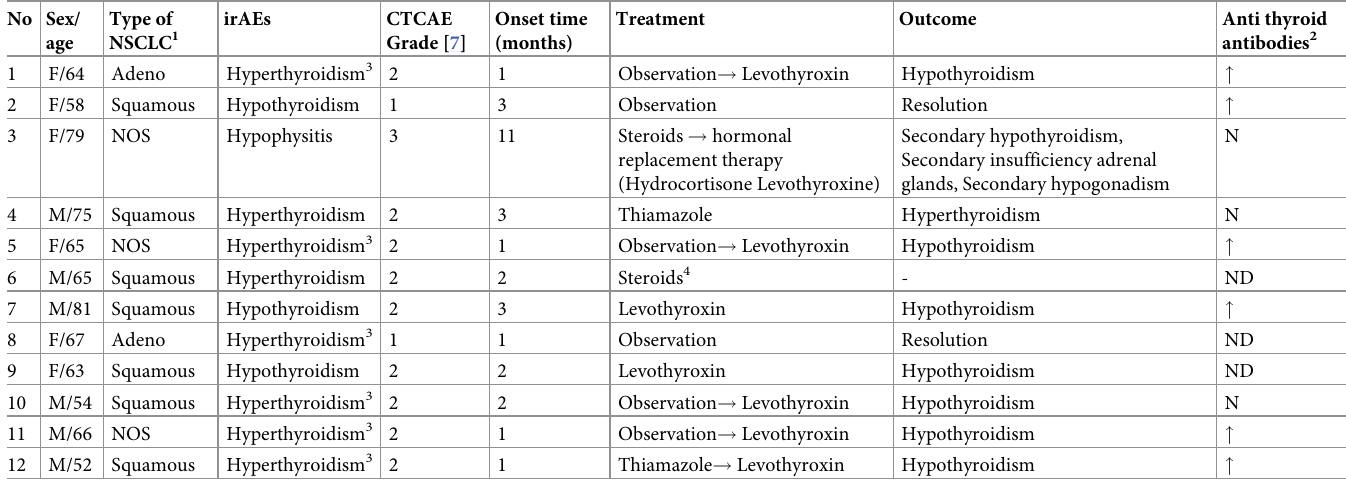
Table 2. Endocrine irAEs among examined